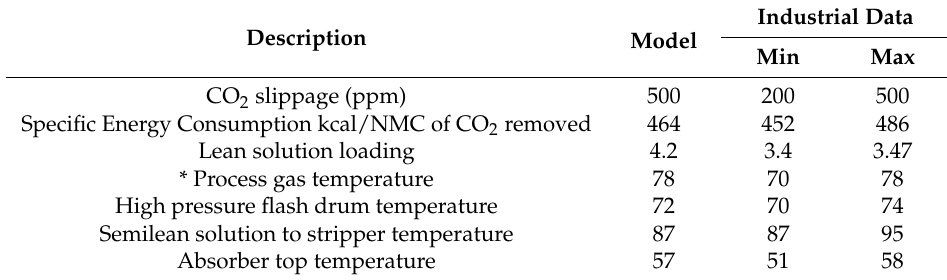
Table 2. Model comparison with real industrial data. The industrial data maximum and minimum is based on the three years with steady state plant conditions. * Process gas temperature is a constraint (boundary condition) for the